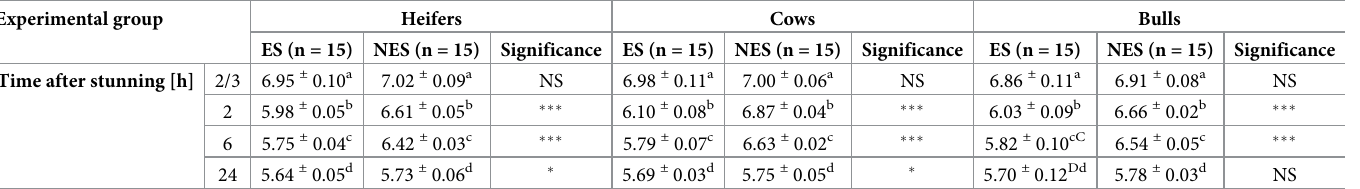
Table 2. Changes in the pH value ( � x ± SD) of the longissimus dorsi muscle of non-electrostimulated (NES) and electrostimulated (ES) heifers, cows, and bulls chilled with the slow method. Experimental group Heifers Time after stunning [h] 2/3 6.95 ± 0.10 a